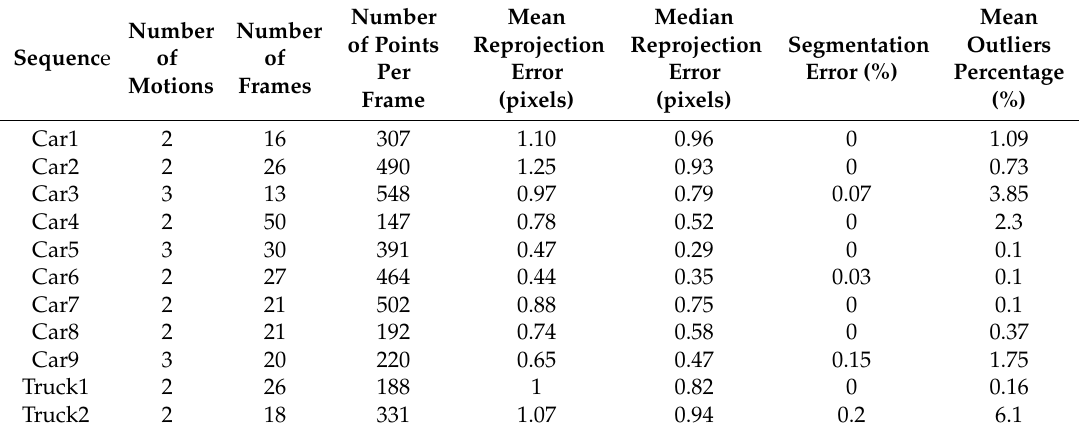
Table 9. TbD-SfM results for Hopkins dataset car